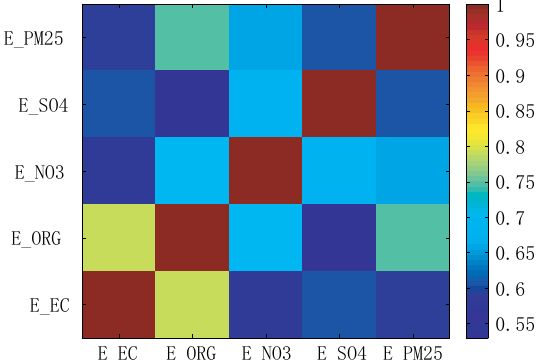
Figure 2. Cross-correlations between emission species of E_EC, E_ORG, E_NO3, E_SO4 and E_PM25. The emission species data are derived from the NEI’05 emissions set for the innermost domain of the WRF/Chem